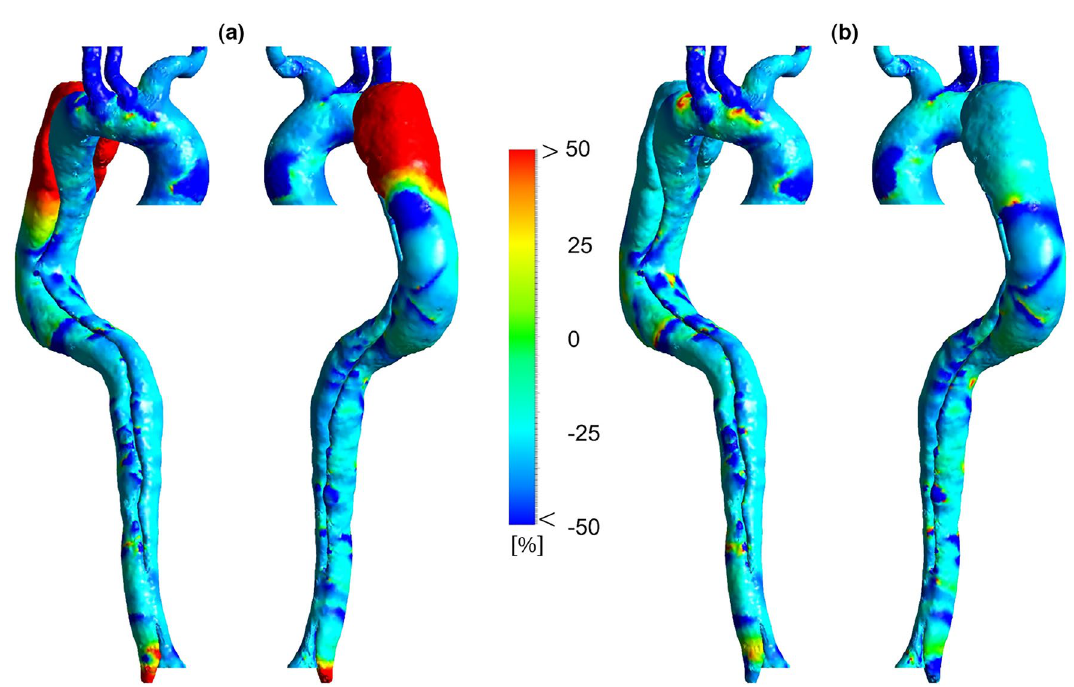
Figure 11. Percentage difference in highly oscillatory, low magnitude shear (HOLMES) according to different heart rates. ( a ) Percentage difference in HOLMES between 86 and 70 BPM. ( b ) Percentage difference in HOLMES between 55 and 70